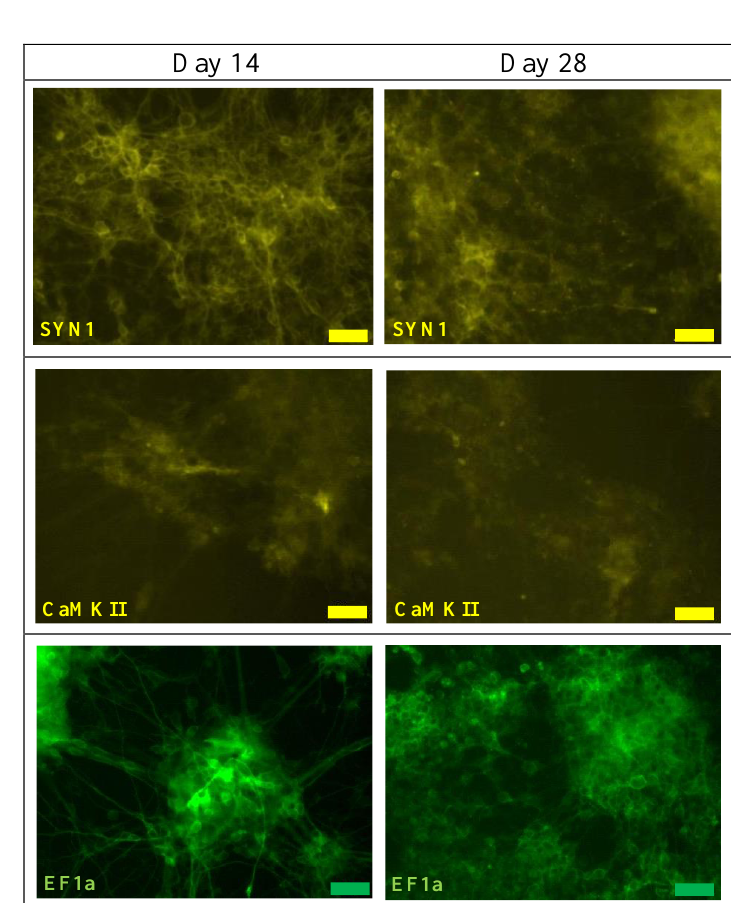
Figure 2. Upon optogenetic modification, neuronal differentiated human SH-SY5Y cells that con- tained neuron-specific promoters, (e.g., SYN1, CaMKII, EFIa) showed a high percentage of viability (>85%), and positive expression of ChR2. ( a ) Cell viability of lentiviral transduced human SH-SY5Y cells under the condition of MOI-2 was analyzed using a trypan blue exclusion test after 7 and 14 days of transduction ( n = 3). ( b ) Efficiency of transduction was evaluated using flow cytometry on days 14 and 28 post-transduction ( n = 3). ANOVA test was used to determine significance; n.s = non- significant; * = p < 0.05 was considered statistically significant. ( c ) Optogenetic constructs, pSNY1- ChR2-YFP and pEF1a-ChR2-GFP were strongly expressed in neuronal differentiated human SH- SY5Y cells; however, pCaMKII-ChR2-YFP showed lower expression. Fluorescence imaging of cells was conducted using fluorescence microscopy (Nikon Eclipse T i -E, Tokyo, Japan). Scale bar: 50 µm .